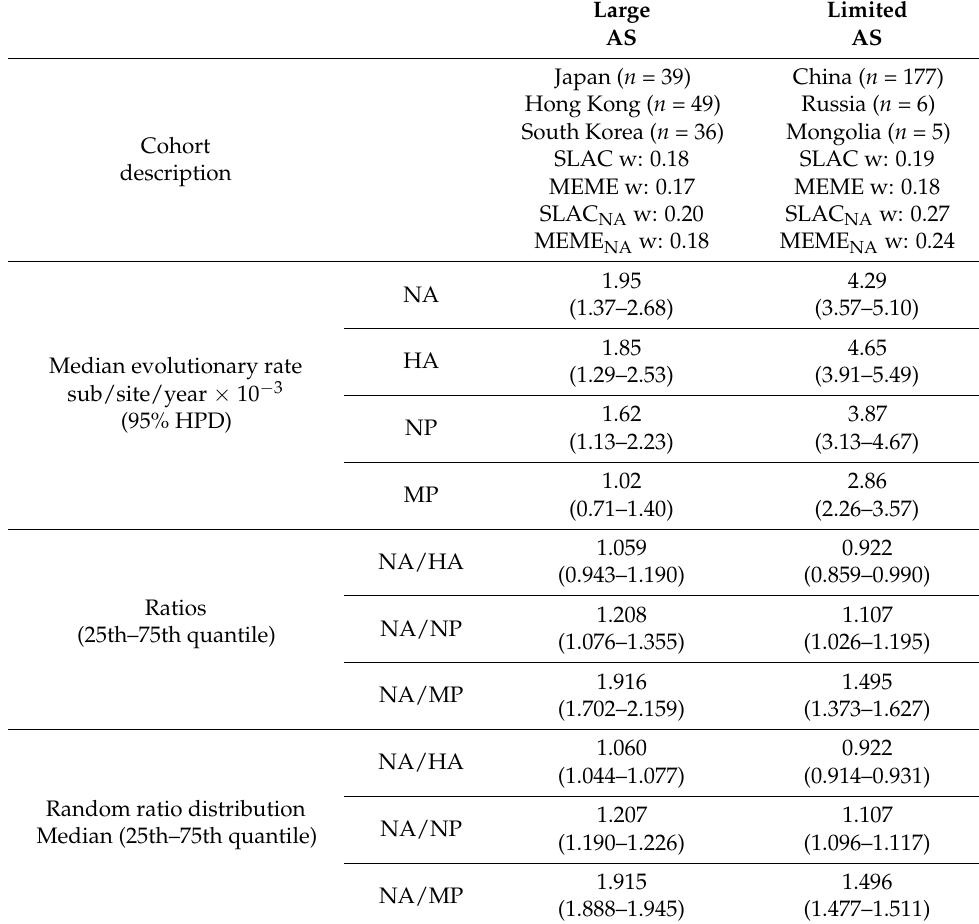
Table 1. Summary of the results. Description of the two cohorts including values related to selective pressure (SLAC and MEME evaluated with the Datamonkey server); the estimated evolutionary rate of the four segments in the two cohorts (95% HPD range is reported in brackets); ratios between NA and the other segments in the two cohorts (25th and 75th quantiles are reported in brackets); distributions of the medians obtained from 1000 random extractions of ratios of both cohorts, for each gene pair (25th and 75th quantiles are reported in